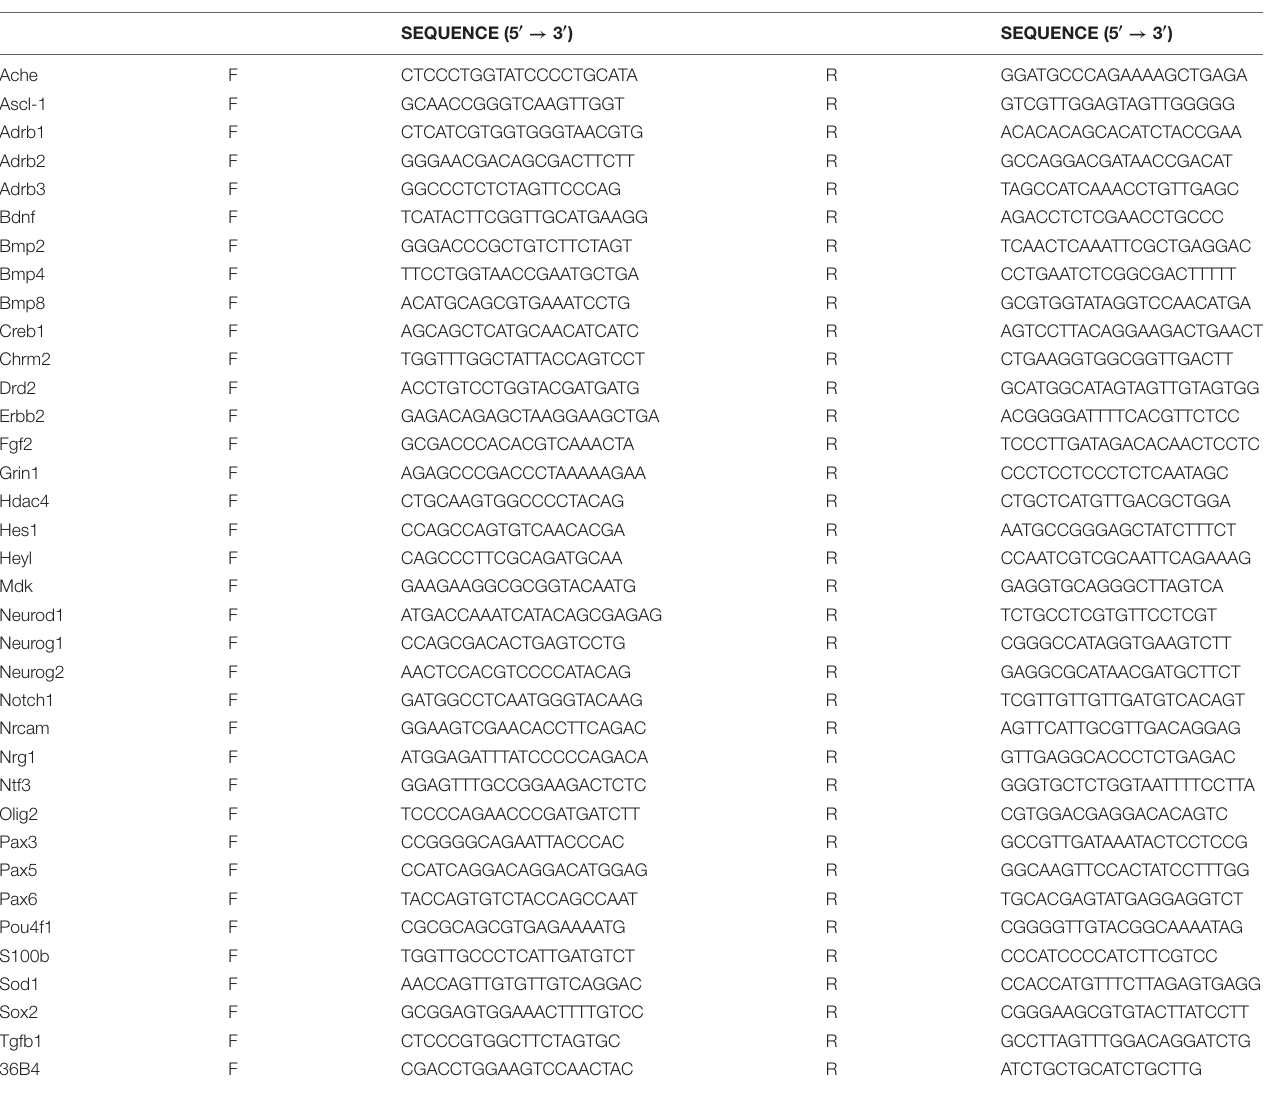
TABLE 1 | Primers used for